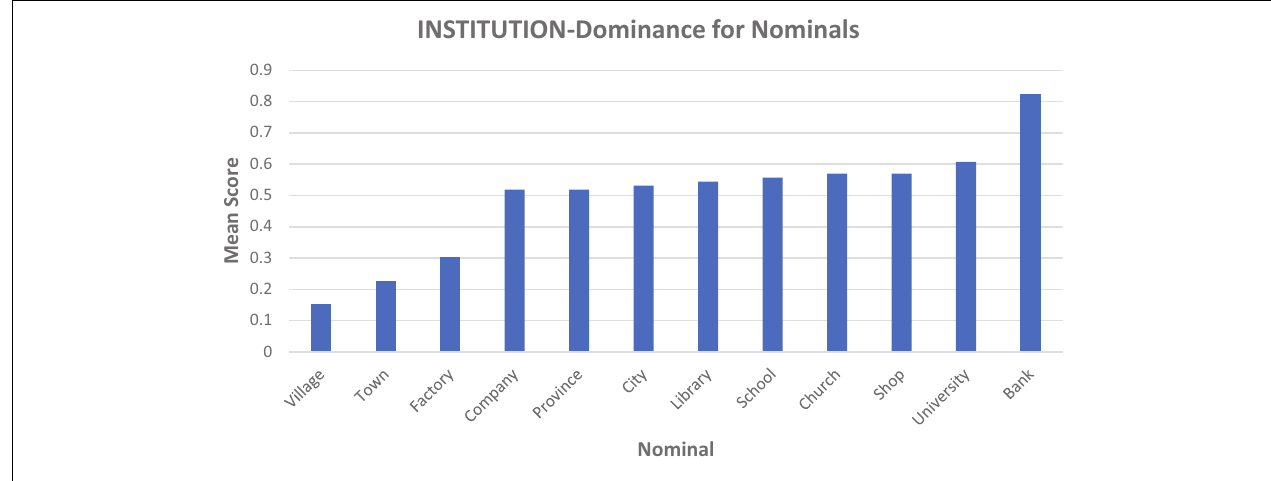
FIGURE 1 | Average scores for all nominals, with the Y -axis representing percentage of Institutional sense selection (0.1 = 10%), where POLITY is subsumed as an institutional sense and narratives involving no explicit institutional sense were sorted such that the sense most approximate to INSTITUTION acted as an institutional proxy (e.g., POPULACE / EMPLOYEES is more semantically related to INSTITUTION than PHYSICAL